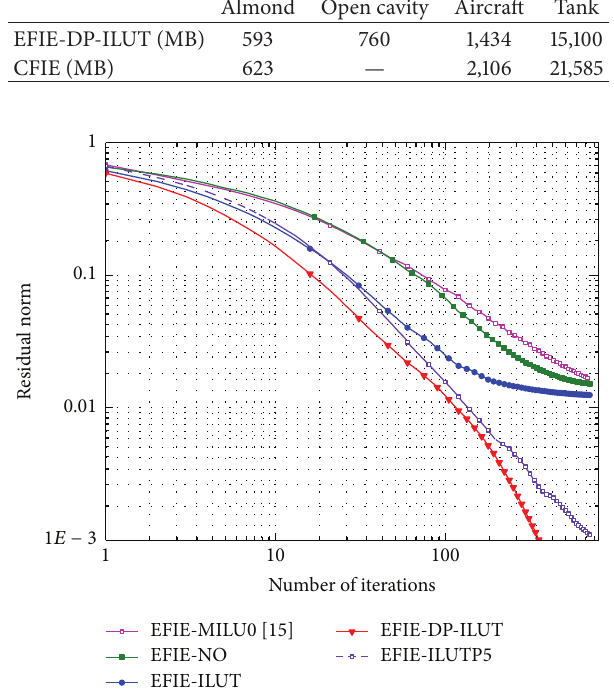
Figure 9: The convergence history of GMRES algorithms with different integral operators and preconditioners in the tank model